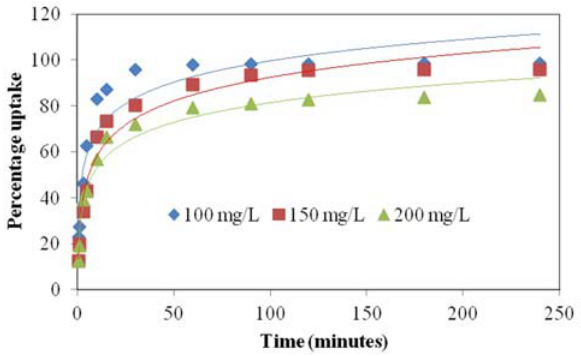
Figure 5. Effect of initial dye concentrations and contact time on adsorption of MB by NTA-BP (Condition: 0.02 g of NTA-BP in 20 mL of MB dye solution at 150 rpm for 4